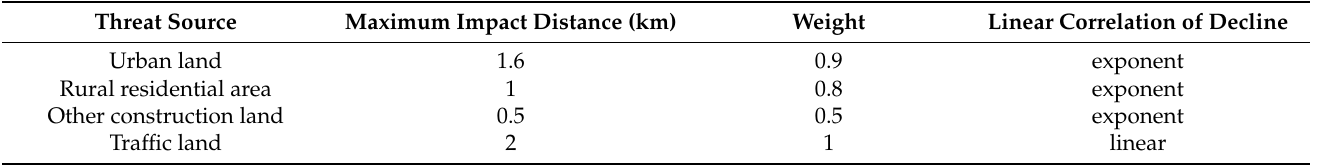
Table 5. Quantitative table of habitat threat